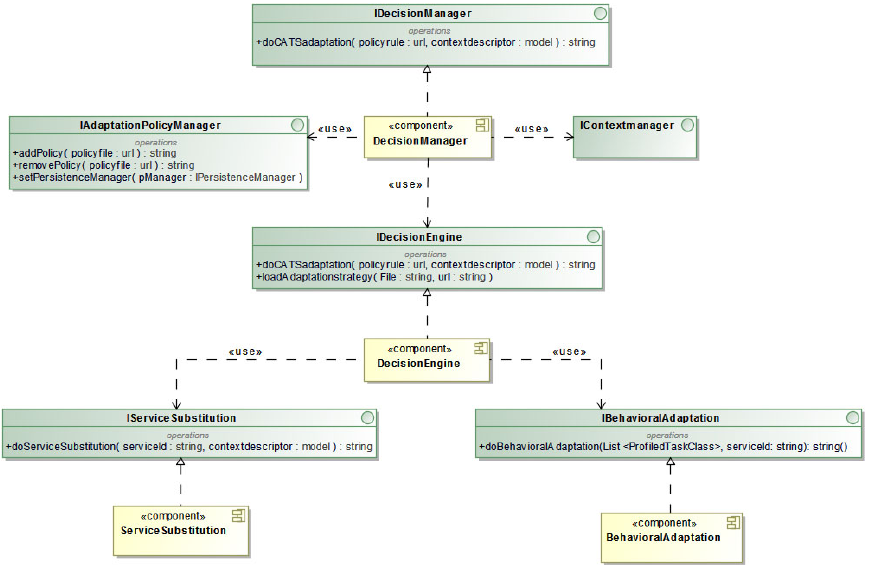
Fig. 4. Components implementing CATS service adaptation